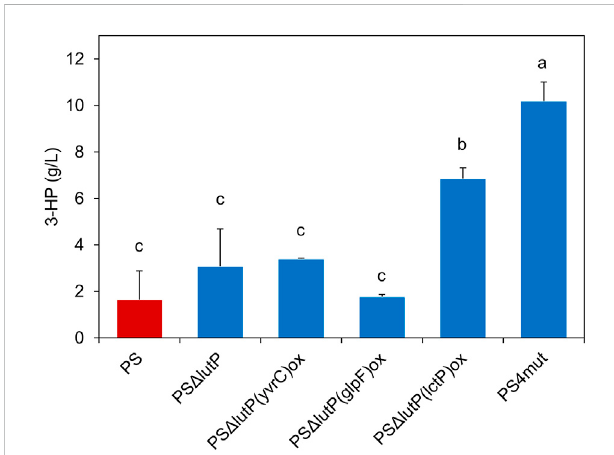
FIGURE 3 3-HP production in the genetically modi fi ed strains PS Δ lutP , PS Δ lutP ( lctP ) ox , PS Δ lutP ( glpF ) ox , PS Δ lutP ( yvrC ) ox and PS4mut compared to the PS grown in shake fl asks after 30 h. The “ * ” represents statistical signi fi cance with p < 0.05. The error bars represent standard deviation (n = 2). Different roman letters show signi fi cantly different means as determined by Tukey ’ s post-hoc test.